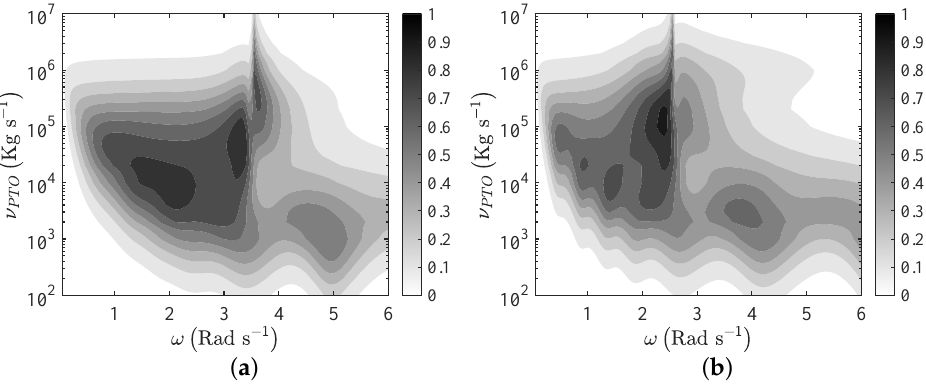
Figure 5. Behaviour of the Capture Factor versus frequency of the incident waves and PTO-Coefficient. ( a ) Ridge height c = 2 m; ( b ) c = 4 m.